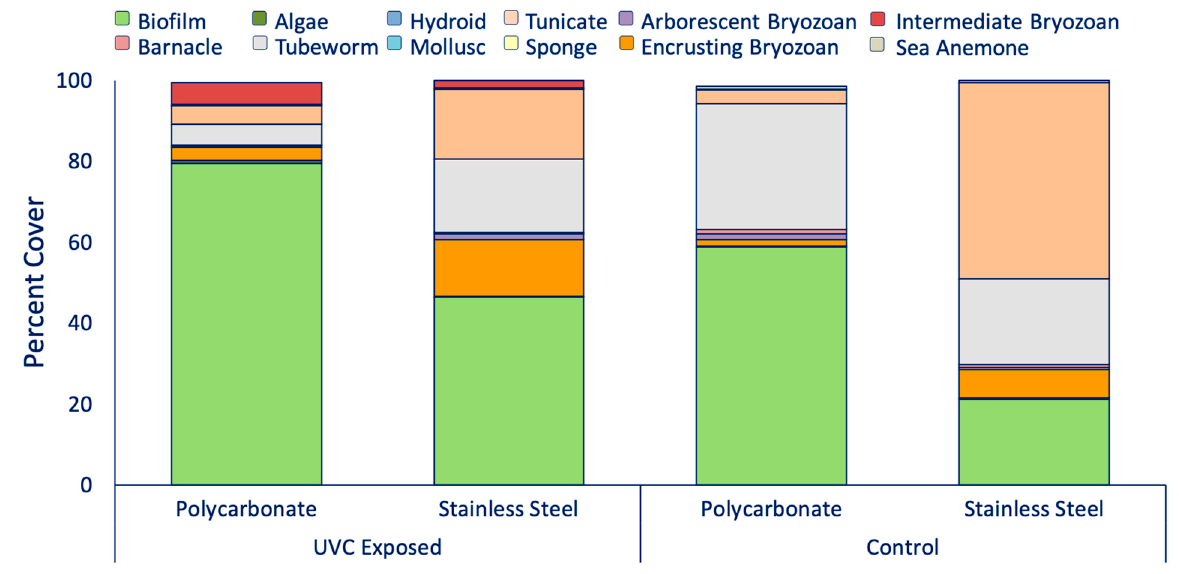
Figure 3. Biofouling composition on the UVC-exposed polycarbonate (average of red and white) and stainless steel panels and their corresponding controls.